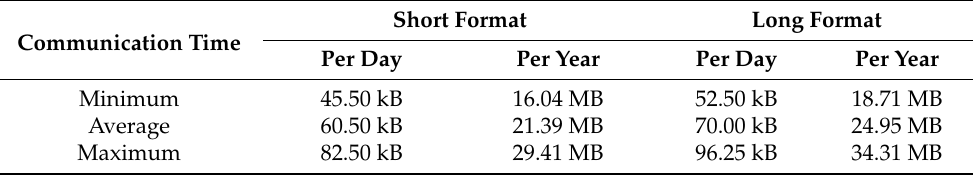
Table 8. Summary of SIoT capacity estimation for one